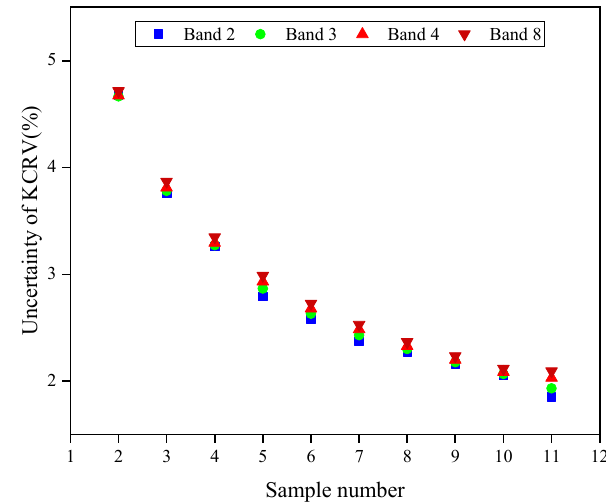
Figure 16. The uncertainty of the KCRV derived with different calibration samples.